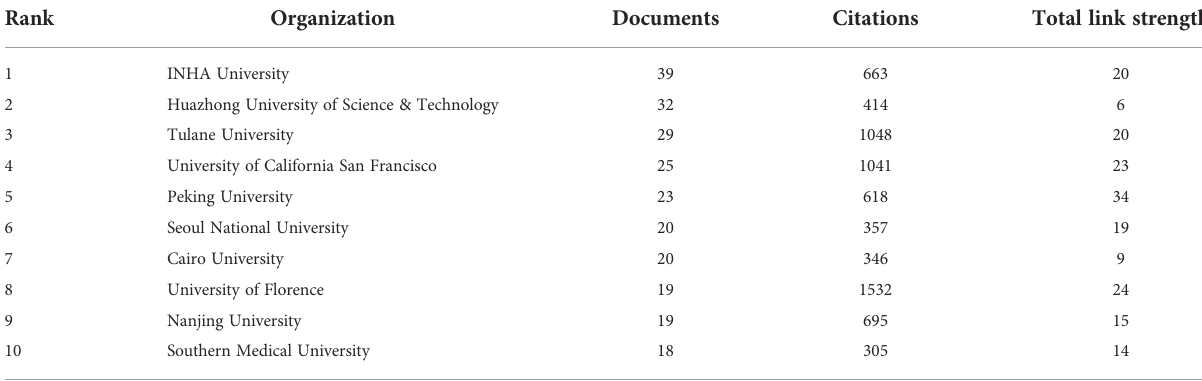
TABLE 3 The 10 institutions that contributed the most publications on assisted reproduction. Rank